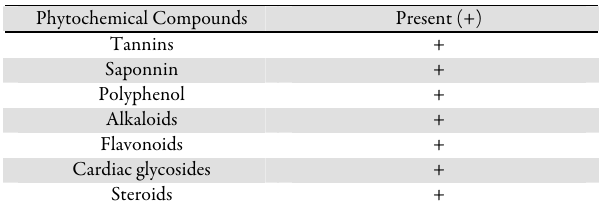
Table 1. Phytochemical compounds present in MSK Phytochemical Compounds